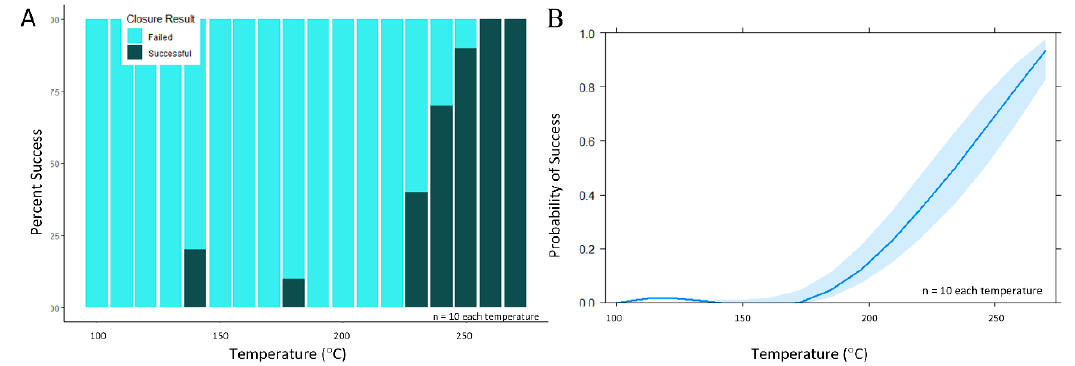
Figure 6. Evaluation of valve closure via the contact heating method over a wider temperature range. ( A ) When pressure and time were held constant (336 ± 75 psi and 3 s, respectively) and as stylus temperature exceeded 230 °C, a sharp increase in channel closure success was noted. ( B ) Broadly speaking, this effects plot visualization of the generalized linear model suggests a rapid increase in the probability of successful closure as stylus temperature increases from 200 to 270 °C.